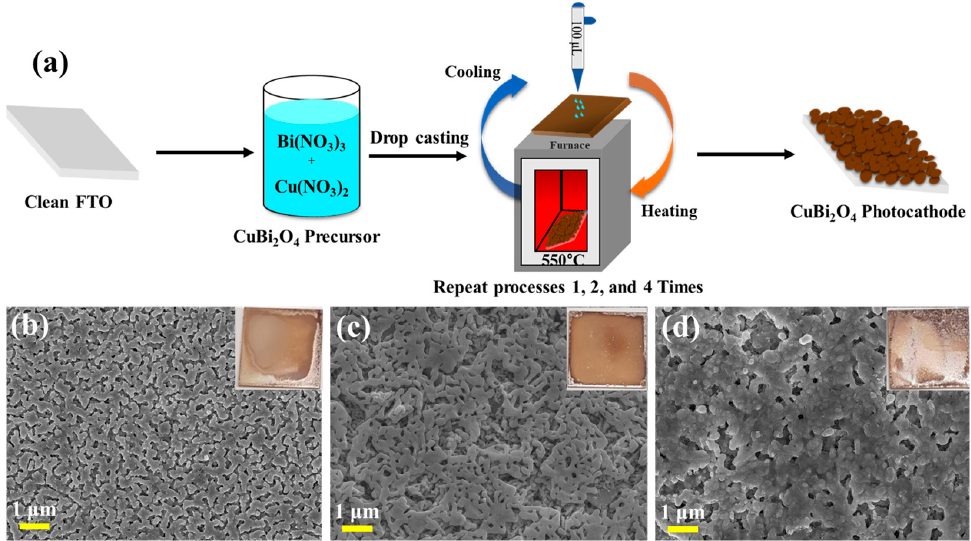
Figure 1. ( a ) Fabrication procedure of CuBi 2 O 4 photocathodes. SEM images of CuBi 2 O 4 . Photocath- odes by the drop casting method: ( b ) #1-CuBi 2 O 4 , ( c ) #2-CuBi 2 O 4 , and ( d ) #4-CuBi 2 O 4